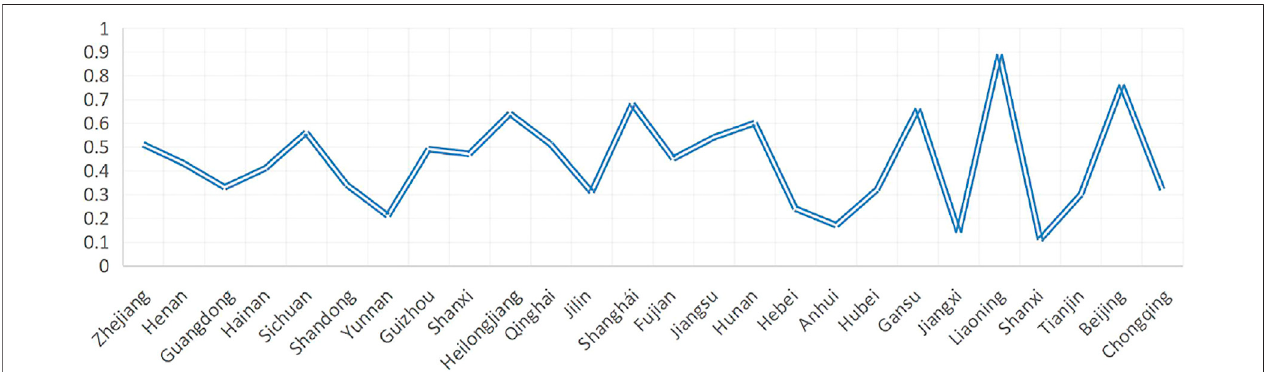
FIGURE 2 | Green fi nancing index outputs.